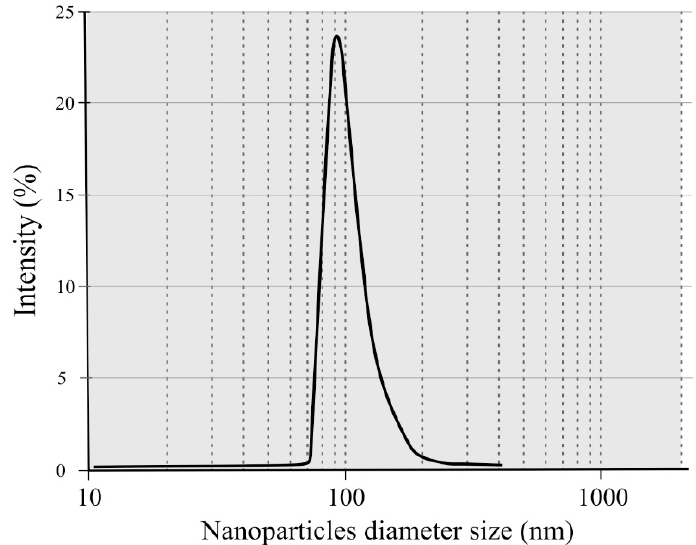
Figure 5. Particle size distribution according to DLS of nanocellulose isolated from banana pseudo-stems.